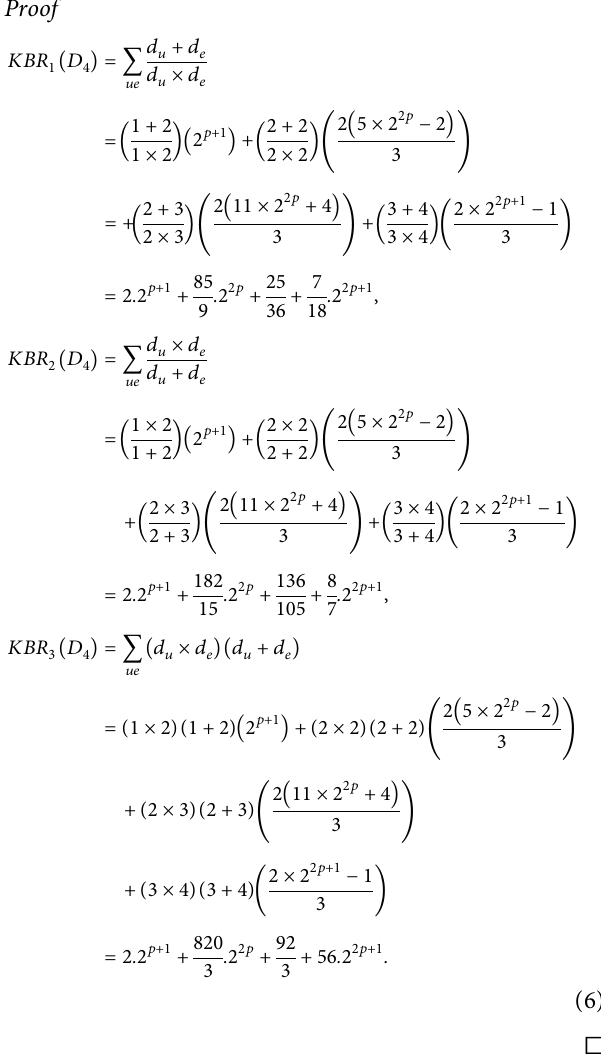
Figure 7: Comparison of KBR